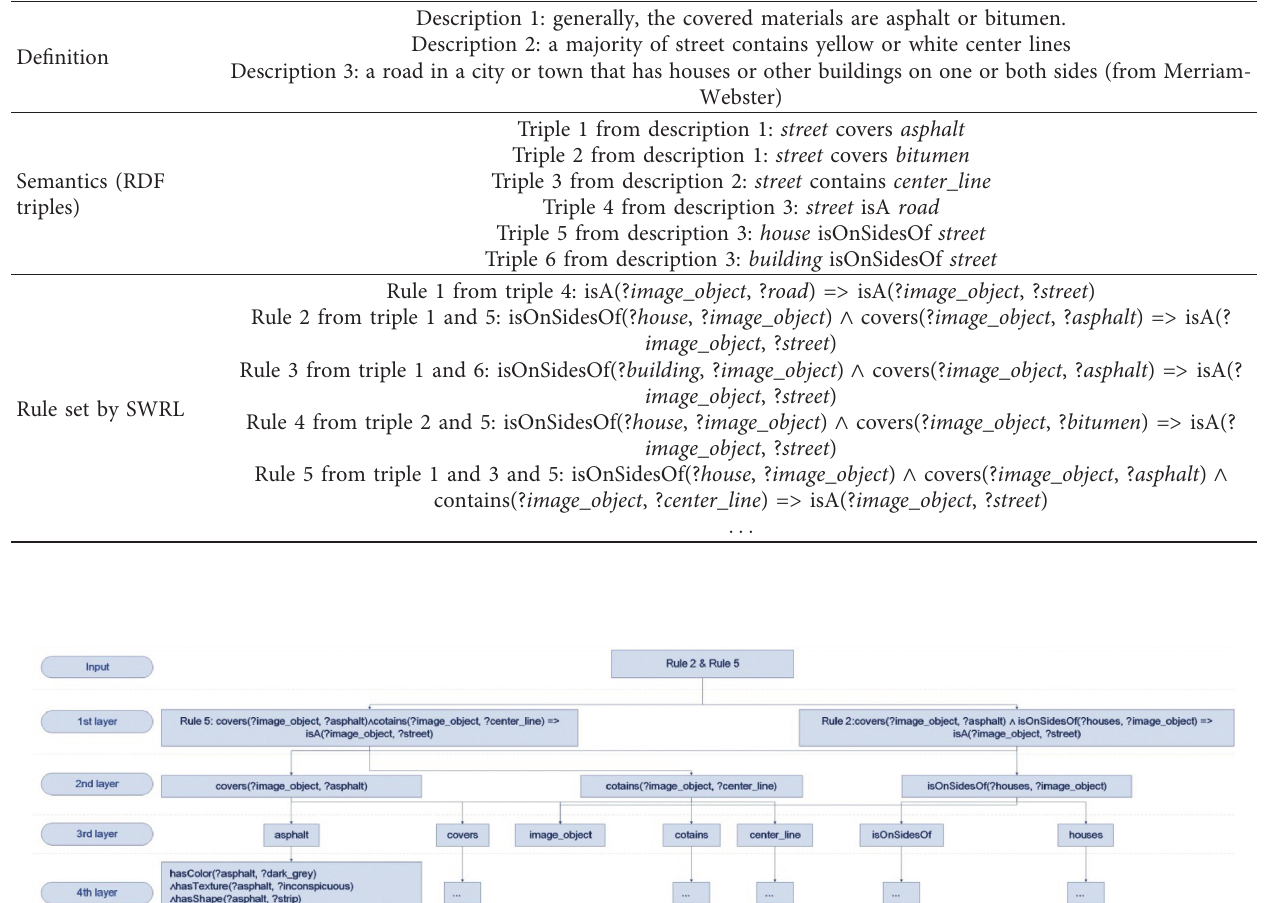
Table 2: Demo of generating semantics and rules in ontology.